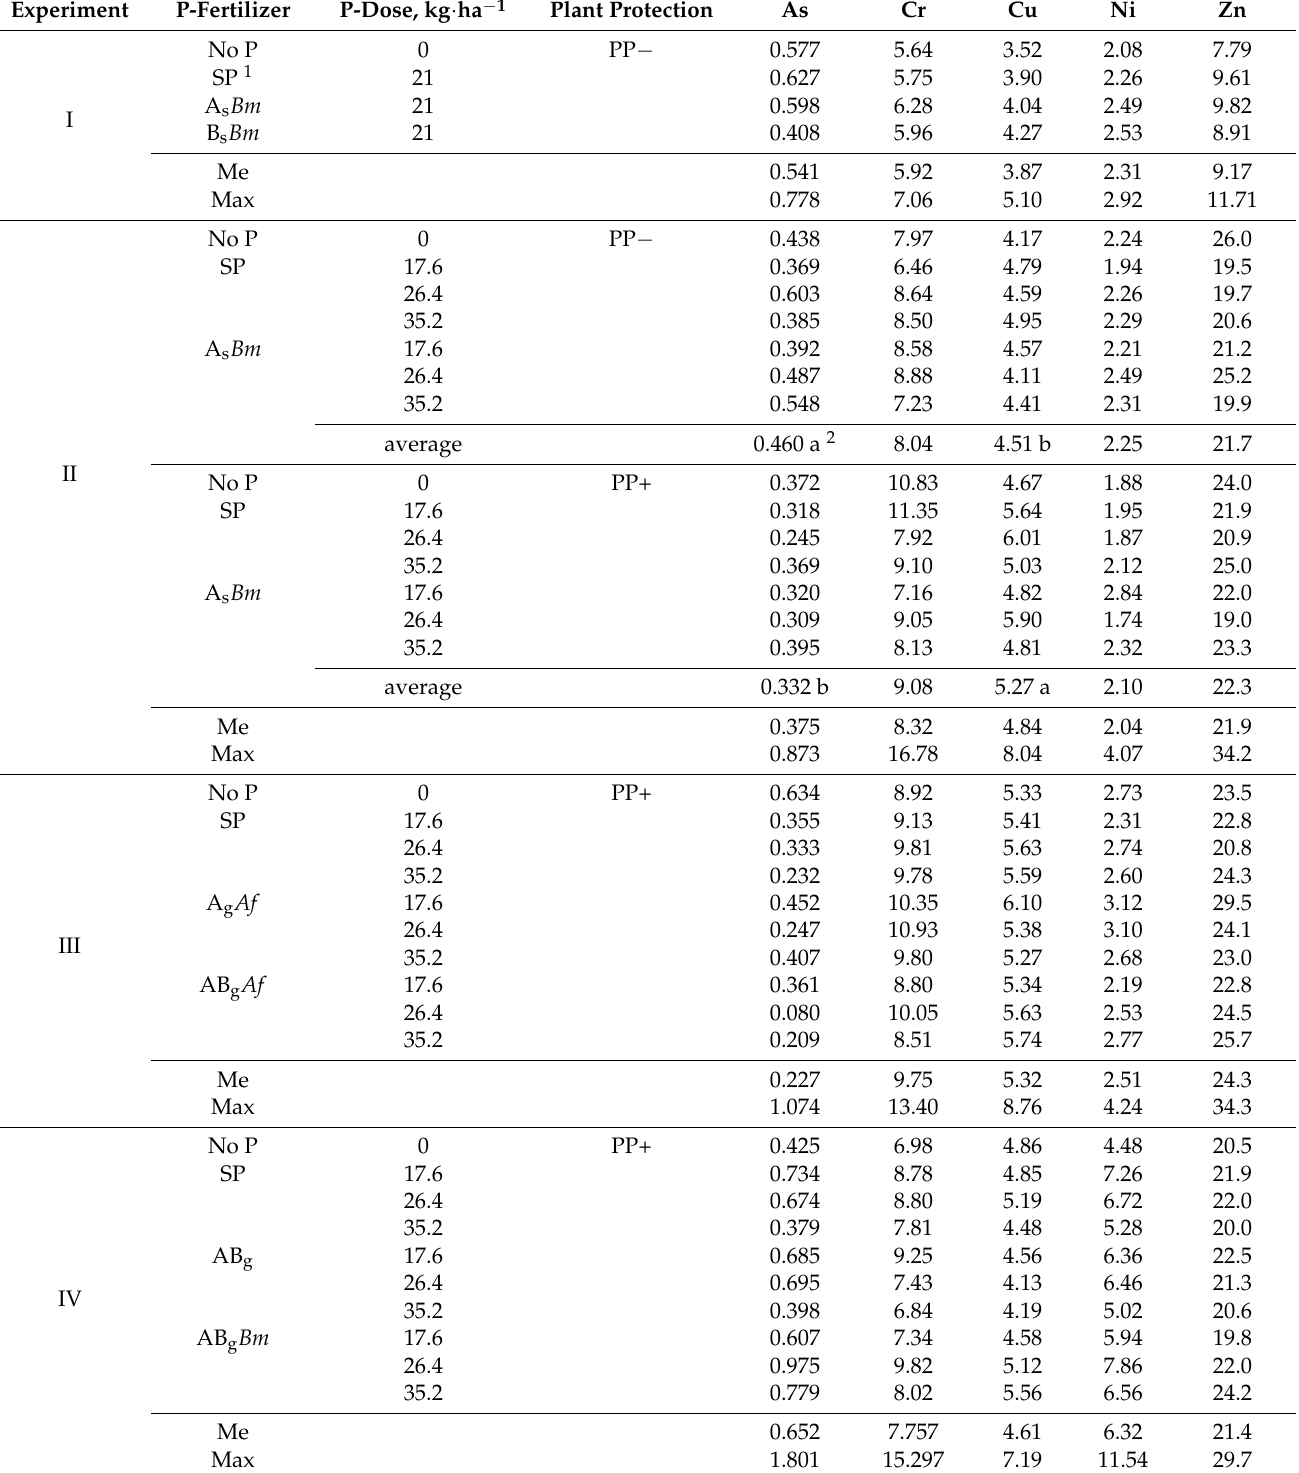
Table 14. PTE content in post-harvest residues, mg · kg − 1 DM (n = 4).